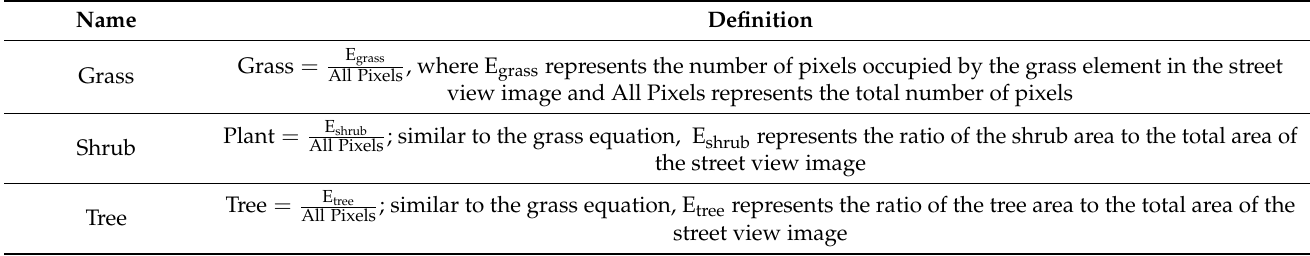
Table 1. Description of the indicators used to quantify the different vegetation types.